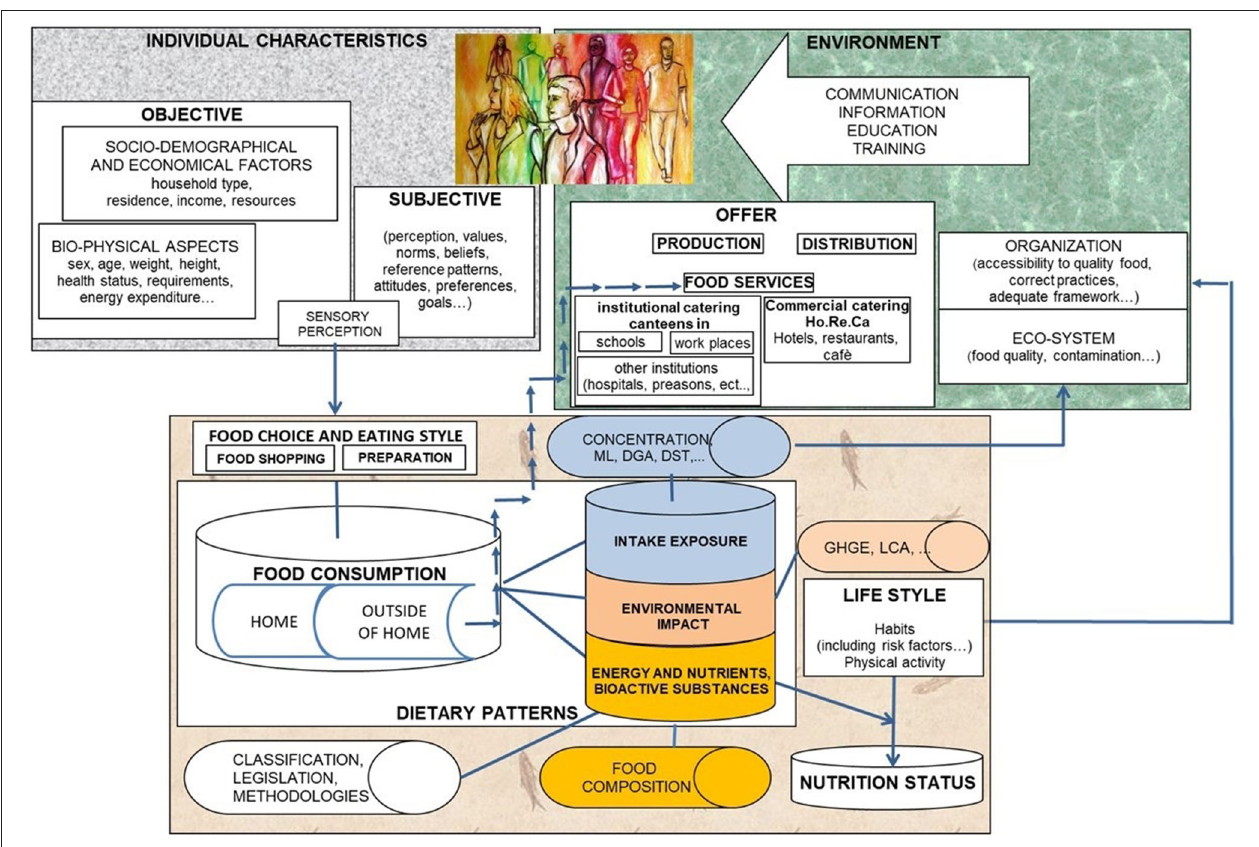
FIGURE 1 | Conceptual scheme of applied research in nutrition—population